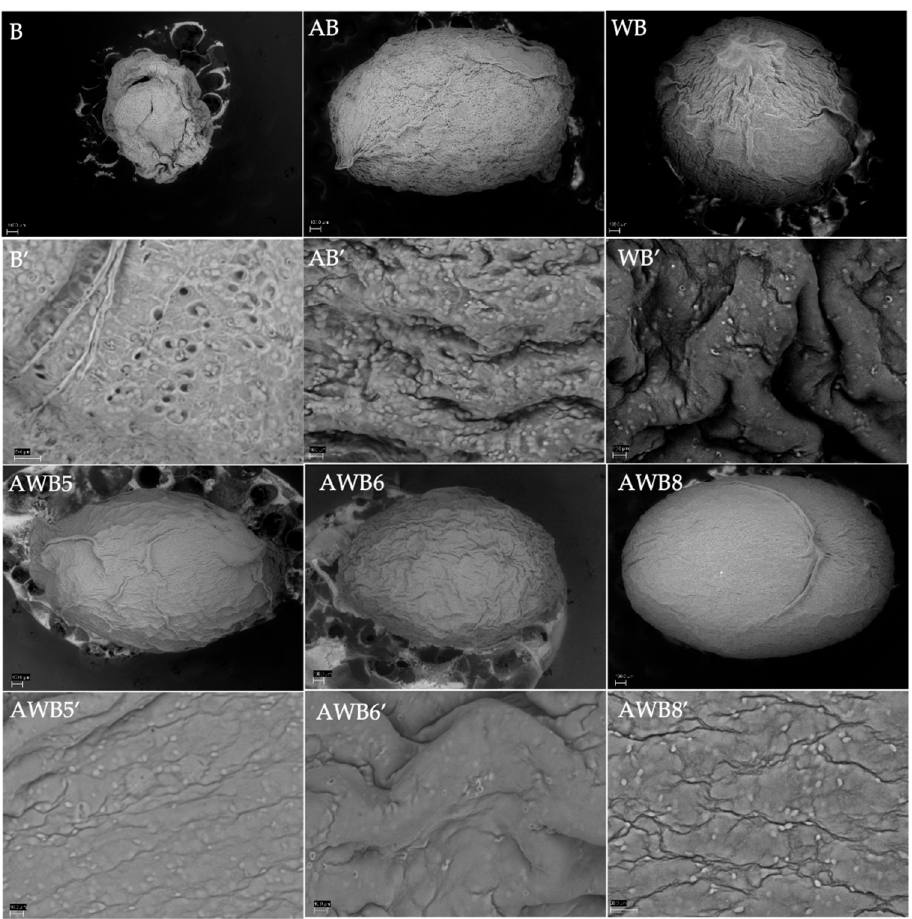
Figure 3. Micrographs obtained by scanning electron microscopy (40x/scale: 100 microns, 500X/scale: 10 microns) of beads with S. boulardii . *Nomenclature with apostrophe (’) indicates zoom to